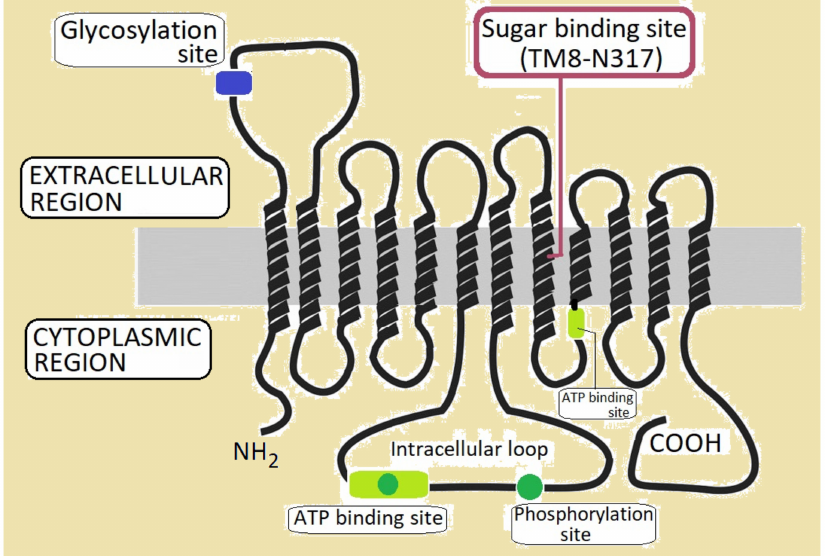
Figure 2. A model of the Glut1 structure with 12 TM domains, and the main functional sites: ATP binding sites, the phosphorylation site, and the sugar binding site in position N317 of the TM8